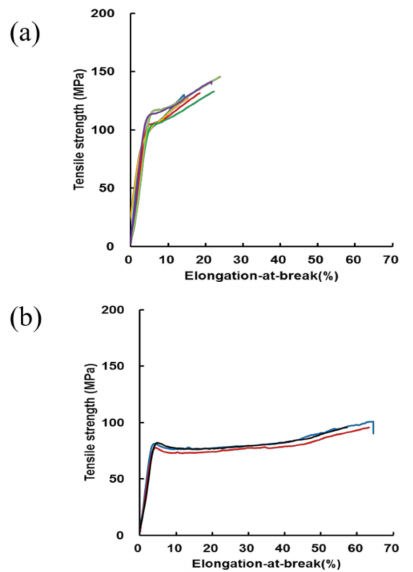
Figure 5. Stress–strain curves of ( a ) RSSP(VLI) fiber prepared by the wet spinning method from FA solutions of RSSP(VLI) powder (storage time in FA was 40 h at 40 and ( b ) RSSP(VLI) fiber after dimensional stability measurement, i.e., repeated immersion of the fiber in water and drying at room temperature. The calculated tensile strength (MPa), elongation‑ at‑break (%), and diameter ( µ m) were ( a ) 134 ± 10, 19 ± 4, and 61.9 and ( b ) 97 ± 3, 62 ± 3, and 59.6,